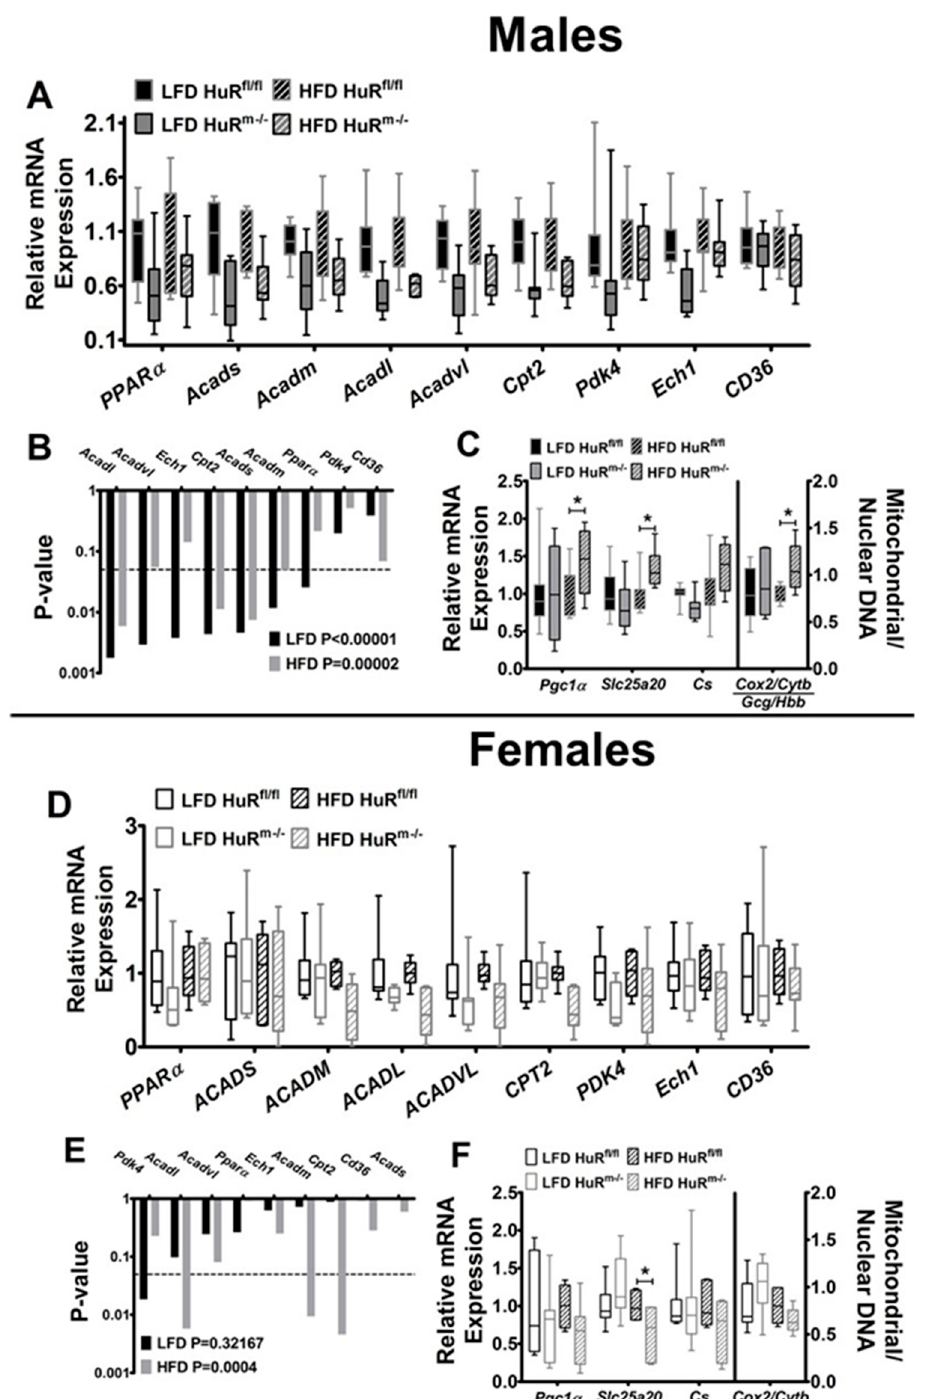
Figure 6. HuR m − / − male but not female mice show increased mitochondrial content on HFD with decreased activation of Ppar α . ( A ) Gene expression profile for transcripts controlled by the lipid oxidation transcription factor, Ppar α are shown for control (black) and HuR m − / − (grey) males on LFD (solid) and HFD (striped). ( n = 7–8) ( B ) Pathway p -value analysis for Ppar α pathway within males fed LFD (black) and HFD (grey). The dashed line indicates p = 0.05. ( C ) Gene expression profile for Pgc1 α and its targets, including mitochondrial DNA are shown for controls (black) and HuR m − / − (grey) on LFD (solid) and HFD (striped). ( n = 5–8). ( D ) Panel A) is replicated for control (black) and HuR m − / − (grey) females on LFD (open) and HFD (striped). ( n = 6–8) ( E ) Pathway p -value analysis for Ppar α pathway within females fed LFD (black) and HFD (grey). The dashed line indicates p = 0.05. ( F ) Gene expression profile for Pgc1 α and its targets, including mitochondrial DNA are shown for control (black) and HuR m − / − (grey) females on LFD (solid) and HFD (striped). ( n = 6–8). * p ≤ 0.05.